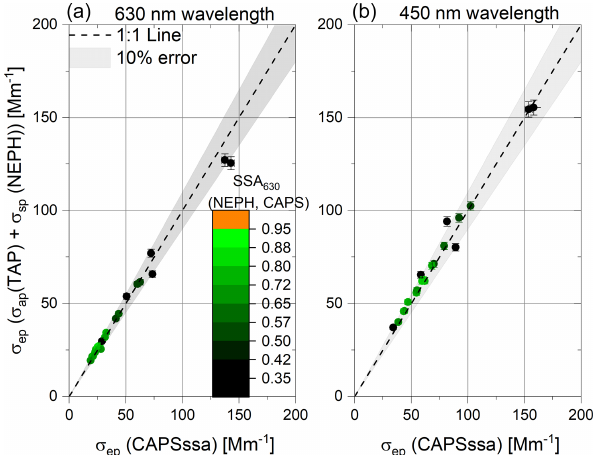
AQ–AS external mixtures at 630nm (a) and 450nm wavelengths (b) . The y axes show the extinction coefficients derived by com- bining TAP absorption and NEPH scattering coefficients versus the CAPS PM SSA direct extinction coefficient measurements. The colour code represents the SSA of the analysed mixed aerosol mea- sured at 630nm wavelength. In addition, an error band of ± 10% was added to the 1 : 1